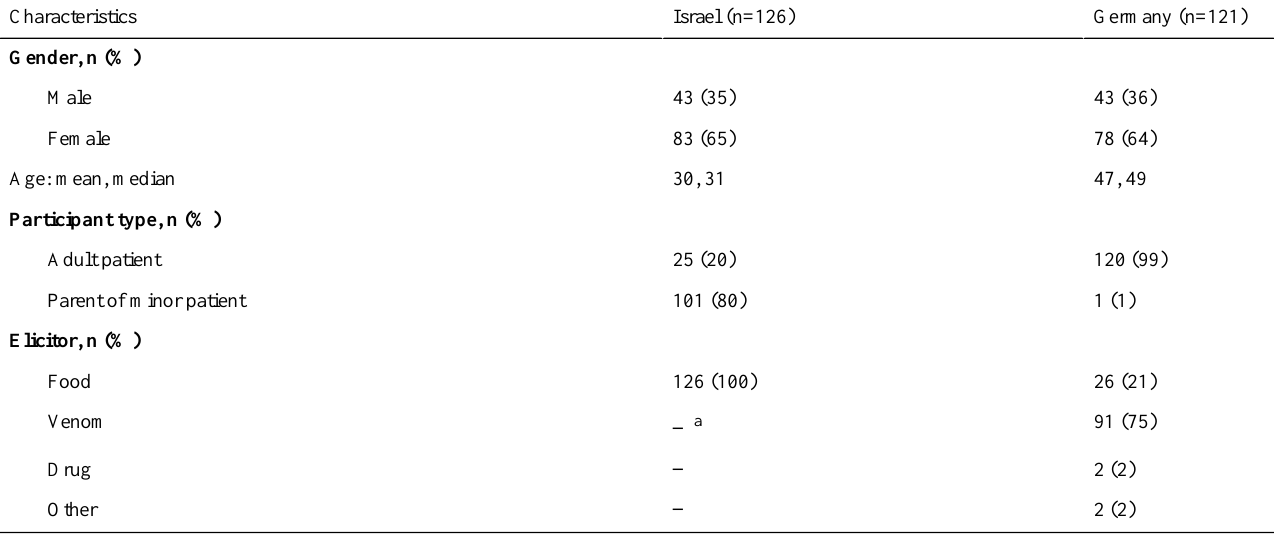
Table 2. Baseline characteristics of the study participants (N=247).